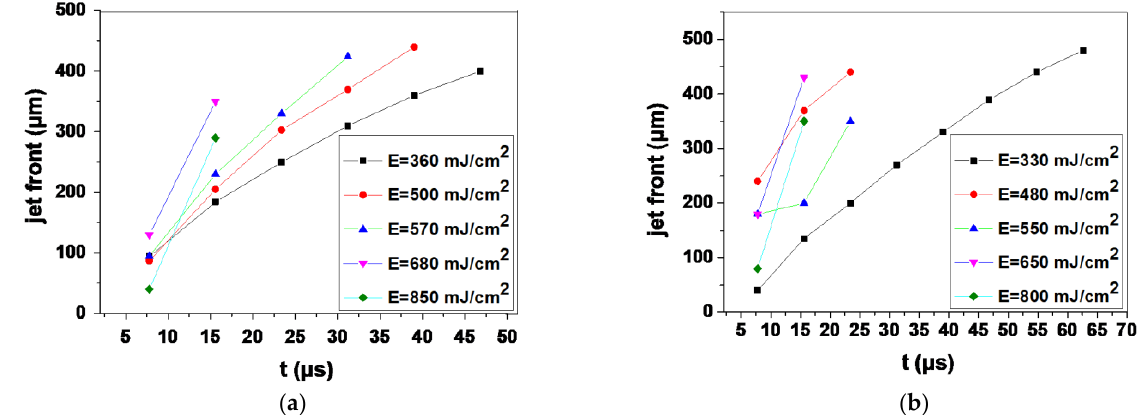
Figure 4. The dependence of the cell suspension jet front position vs. time. ( a ) at 532 nm and ( b ) at 355 nm for various laser fluences.